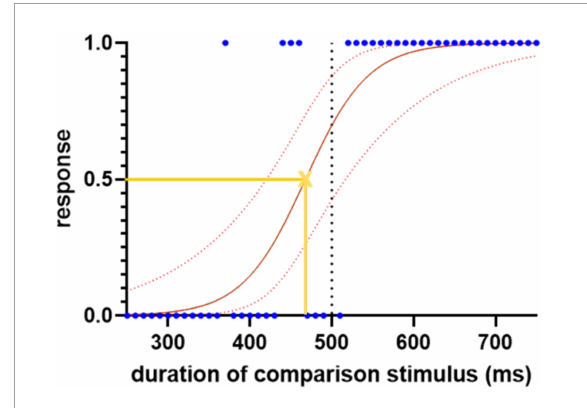
FIGURE1 Sample logistic regression curve for the subseconds interval, demonstrating the spread of the responses, 0 indicates “shorter” and 1 indicates “longer.” The blue dots represent each response. The solid red line represents the fitted logistic regression curse and the dotted red lines indicate the 95% confidence intervals. The yellow cross represents the point of subjective equality where the participant has equal likelihood to choose either “shorter” or “longer” responses. The slope of the curve at this point, and the shift of its 50% point from the standard duration (500 ms), are used to quantify the sensitivity and error of time perception,